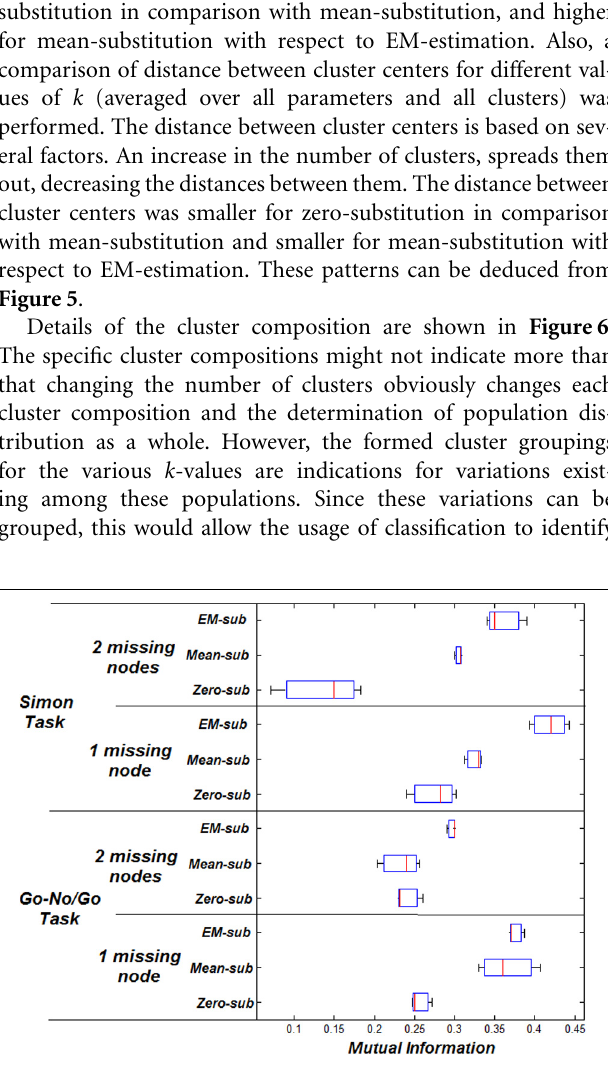
FIGURE 3 | RMSE between initial and final parameters for both datasets.